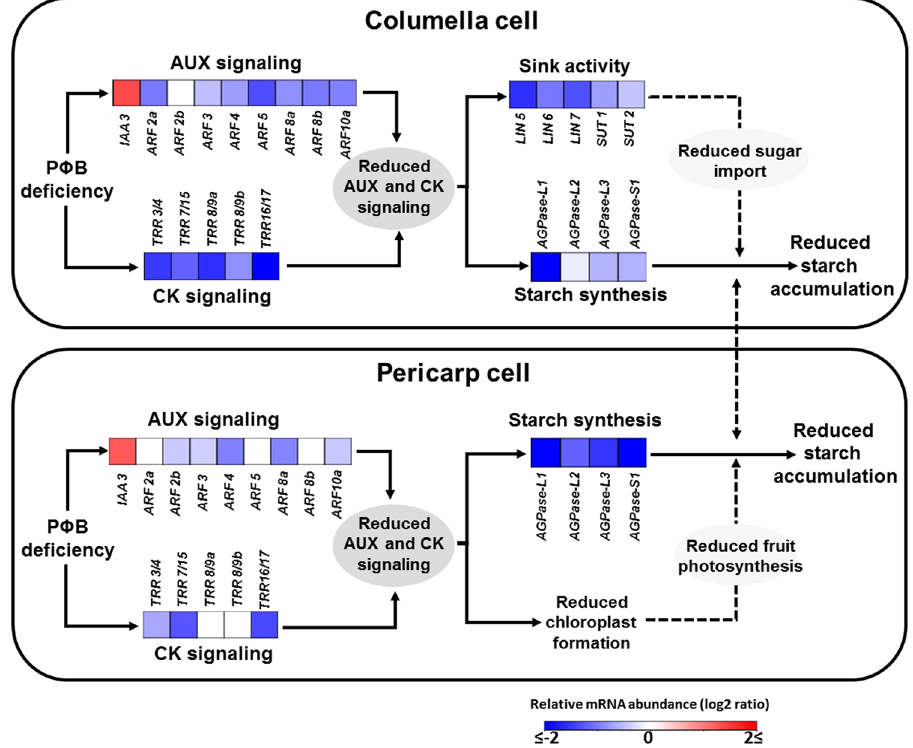
Figure 8. Impact of phytochrome chromophore deficiency on auxin and cytokinin signaling and its potential influence on sugar metabolism and plastid development during early tomato fruit development. At immature green stage, phytochrome chromophore phytochromobilin (P Φ B) deficiency upregulates AUXIN/INDOLE-3- ACETIC ACID3 ( Aux/IAA3 ) and downregulates AUXIN RESPONSE FACTOR ( ARF ) and type-A TOMATO RESPONSE REGULATOR ( TRR ) genes in both columella and pericarp tissues, consequently leading to reduced auxin (AUX) and cytokinin (CK) signaling output in both of these fruit regions. In columella cells, the P Φ B-deficiency-triggered reduction in AUX and CK signaling downregulates genes encoding key enzymes involved in starch synthesis, such as ADP-glucose pyrophosphorylase (AGPases), and sink activity, such as cell-wall invertases (LINs) and sucrose transport proteins (SUTs). In pericarp cells, similar P Φ B-deficiency- triggered changes in hormonal signaling inhibit both starch biosynthesis and chloroplast formation. The downregulation of sink-related genes in columella is believed to reduce sugar import to the fruit, whereas the impaired chloroplast formation in pericarp cells may restrict local photoassimilate production via fruit- localized photosynthesis. Therefore, the reduced fruit starch accumulation in P Φ B-deficient plants may be associated with the more limited sugar import and fruit photosynthesis in this genotype. Arrows at the ends of lines indicate stimulatory influence. Dotted lines indicate hypothesized mechanisms. Transcript abundance data were expressed as the ratio between qPCR values obtained in P Φ B-deficient ( aurea ) and wild-type samples at the immature green 2 (IG2) stage, corresponding to early fruit